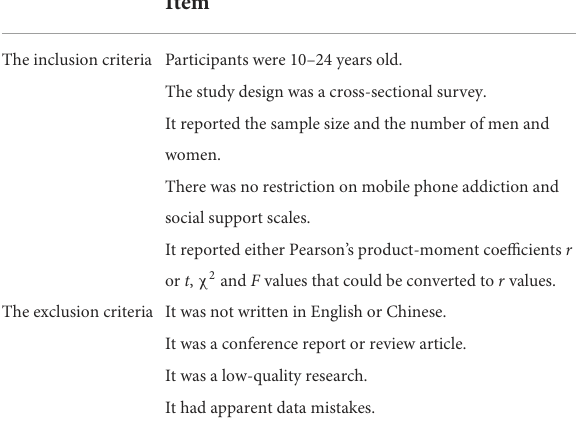
TABLE 1 Inclusion and exclusion criteria of the